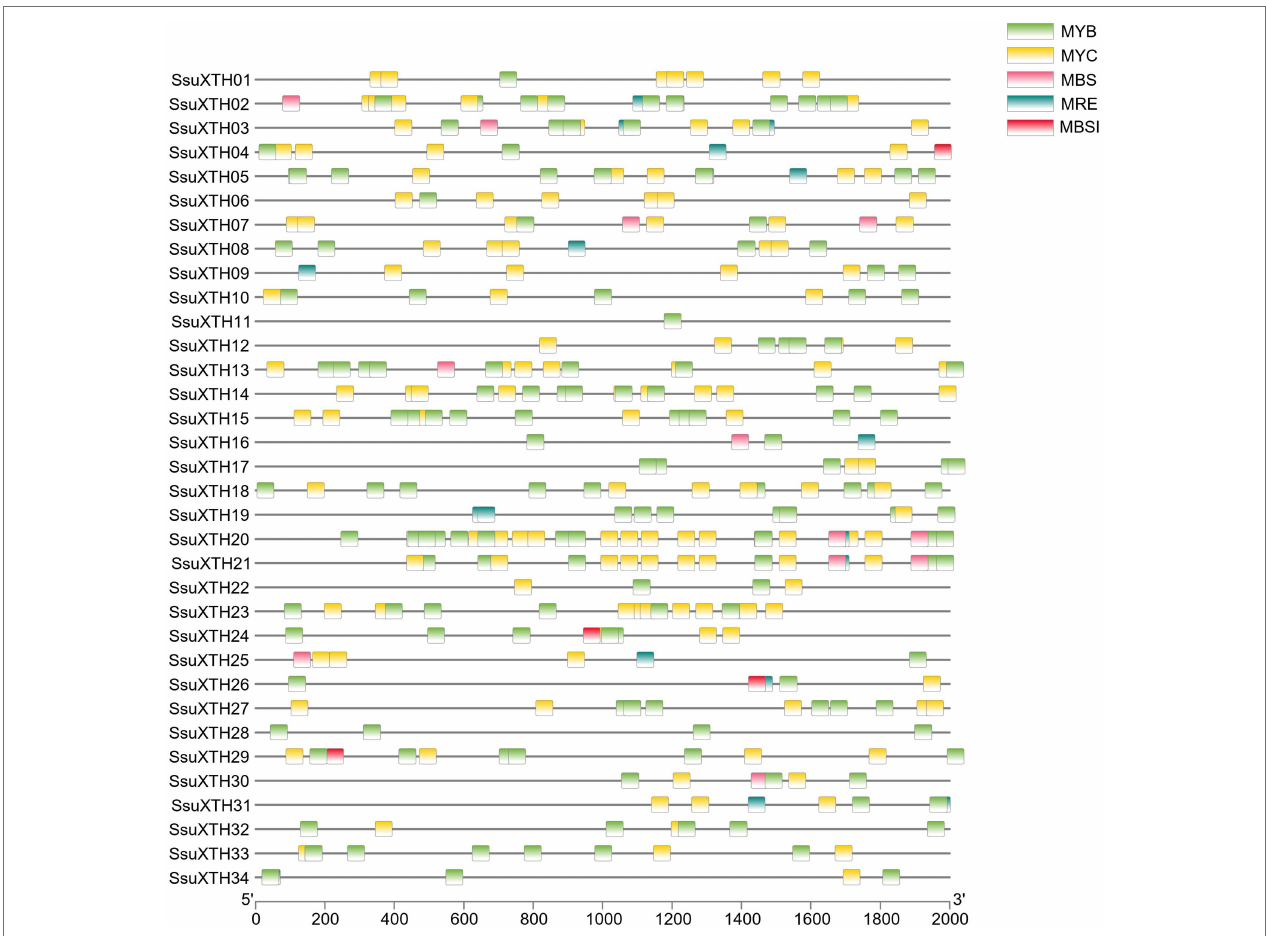
FIGURE 4 | Analysis of the MYB and MYC binding sites in the promoter regions of SsuXTH genes. The 2-kb sequences of SsuXTH gene promoter regions were extracted and analyzed, and the different binding sites were color-coded. MBS: MYB binding site involved in the drought response; MRE: MYB binding site involved in light responsiveness; MBSI: MYB binding site involved in flavonoid biosynthetic gene